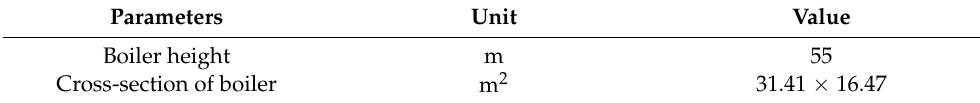
Table 2. Geometric parameters of the boiler.